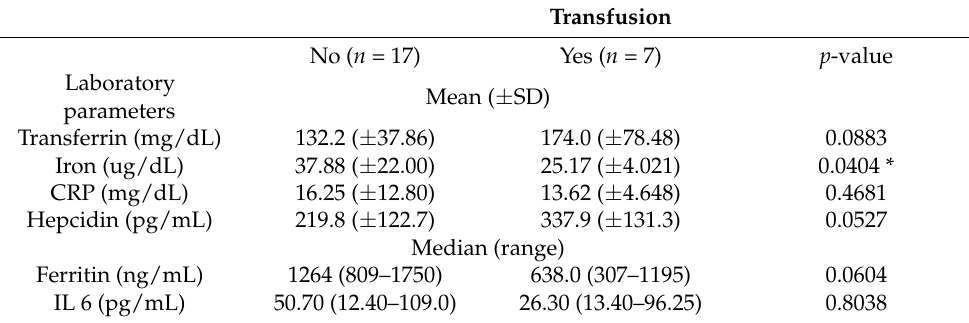
Table 4. Serologic parameters in not transfused (green) vs. transfused (purple)